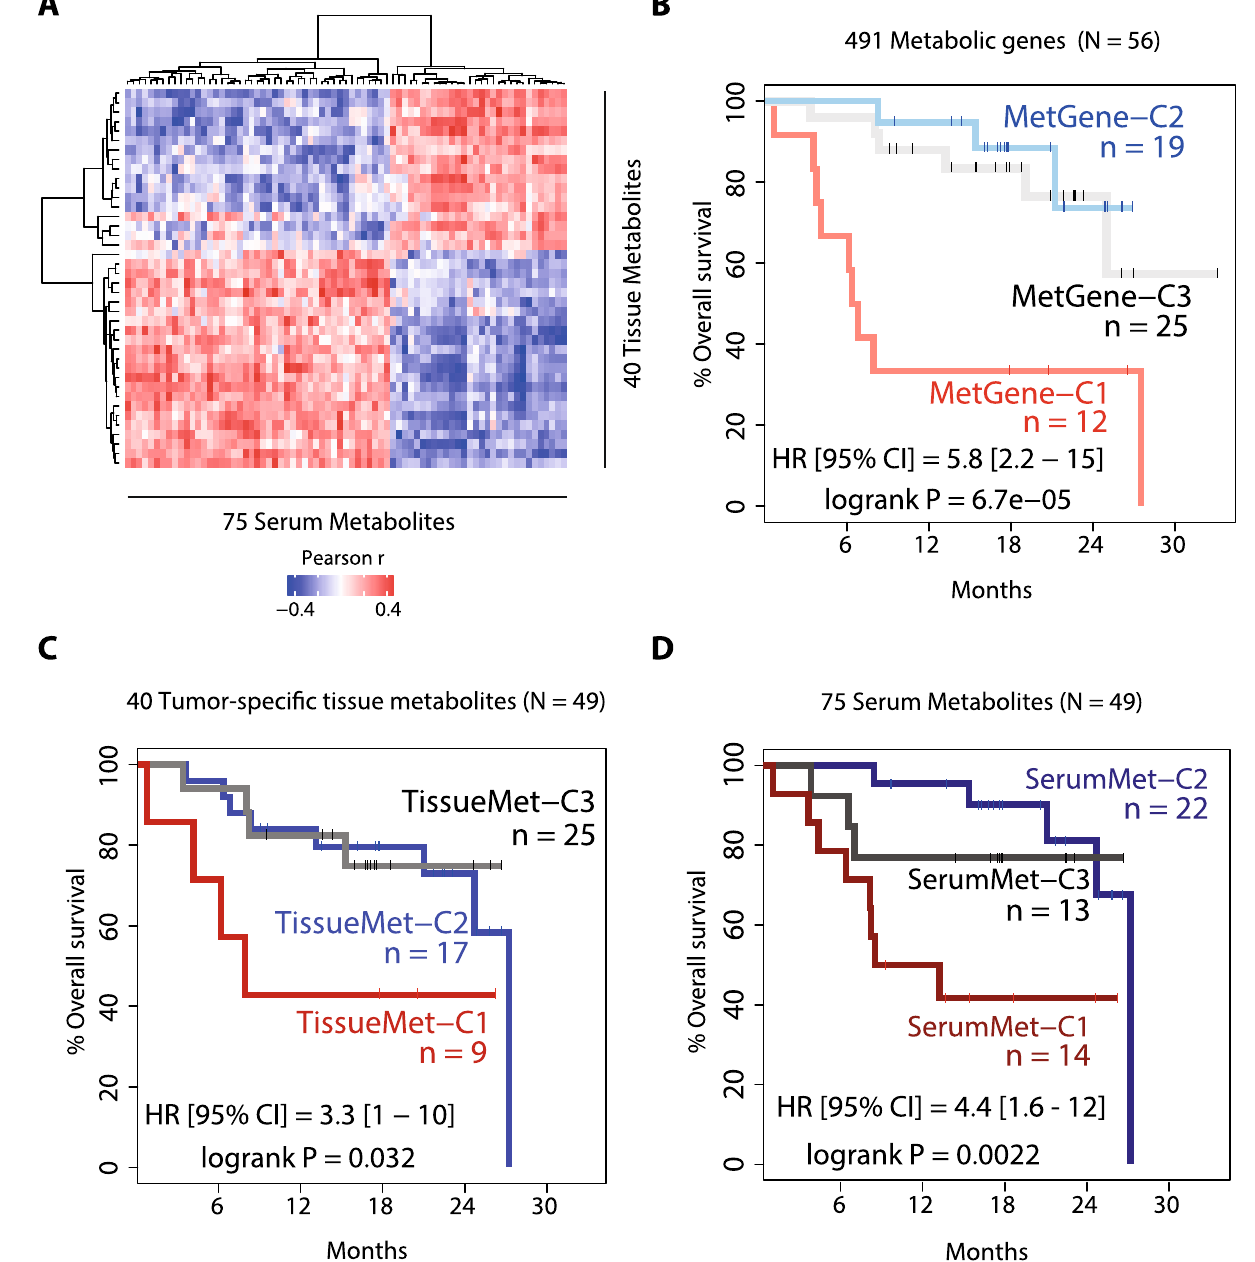
Figure 3. Correlation analysis of tissue and serum metabolites. ( A ) Heatmap of correlation coefficients between 40 tumor-specific tissue metabolites and 75 serum metabolites identified in this study. ( B ) Kaplan–Meier plot showing survival probabilities of HCC patients from TIGER-LC cohort according to consensus clustering based on expression of 491 metabolic genes. ( C ) Kaplan–Meier plot showing survival probabilities of HCC patients from TIGER-LC cohort according to consensus clustering based on abundance of 40 tumor-specific metabolites. ( D ) Kaplan–Meier plot showing survival probabilities of HCC patients from TIGER-LC cohort according to consensus clustering based on abundance of 75 serum metabolites. Abbreviations: HR [95% CI]—Hazard Ratio with 95% confidence interval; MetGene-C—Metabolic gene-Cluster; TissueMet-C—Tissue metabolite-Cluster; SerumMet-C—Serum subgroups. This data concur with the notion that short-chain acylcarnitines in SerumMet-C2 subgroup have the most abundant level among all the subgroups.